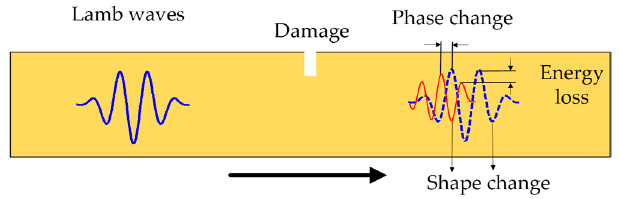
Figure 5. The illustration of the Lamb wave traveling through a damaged region.